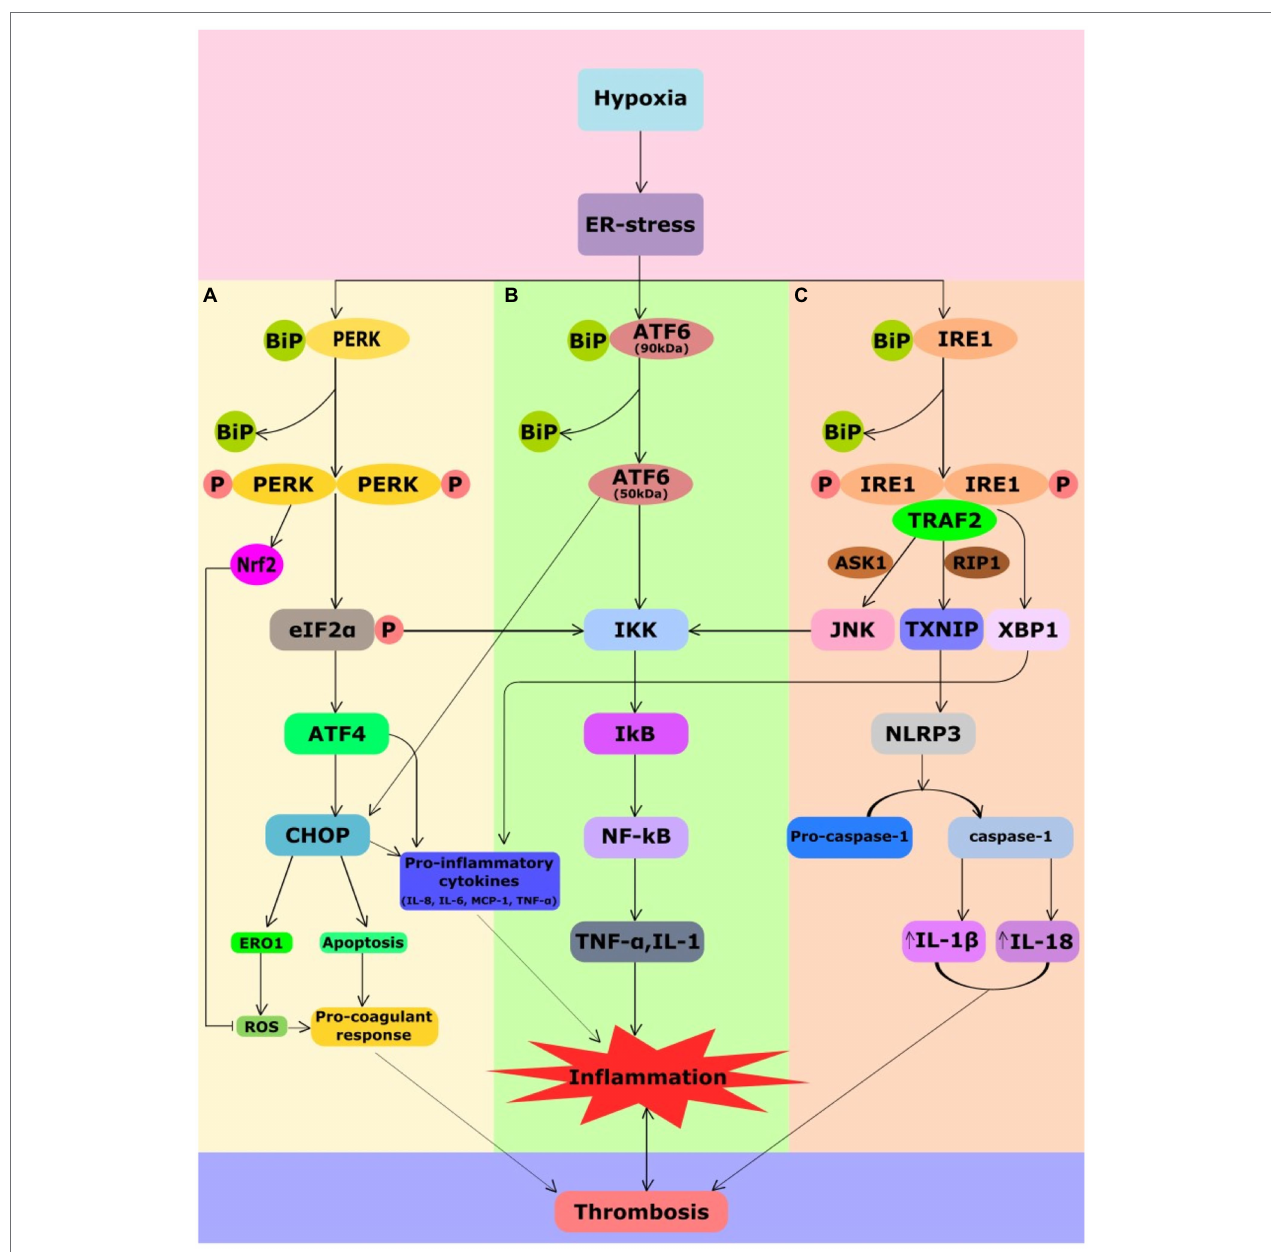
FIGURE 2 | Crosstalk between UPR, inflammatory and coagulation pathways in hypoxia-induced thrombosis. Hypoxia causes ER stress that leads to activation of UPR signaling. UPR signaling comprises three sensor proteins PERK, IRE1, and ATF6. All the three branches of sensor proteins could cause inflammation. Under normal conditions, UPR sensor proteins are bound to ER chaperone, BiP, due to which these sensors remain inactivated. During ER stress, BiP dissociates from them leading to their activation. (A) Phosphorylation of eIF2a by PERK attenuates translation but selectively favors ATF4 translation. ATF4 favors CHOP expression that mediates generation of ROS, apoptosis, and release of pro-inflammatory cytokines promoting inflammation and pro-coagulant response. Although PERK-mediated Nrf2 has an antioxidant response, chronic ER stress can still lead to inflammation and pro-coagulant response. PERK-mediated attenuation of translation leads NF-kB translocation to the nucleus that regulates cytokine encoding TNF- α and IL-1 genes. (B) ATF6 branch of UPR also mediates expression of CHOP and NF-kB promoting inflammation. (C) Activated IRE1 splices XBP1 pre-mRNA to yield the spliced XBP1 mRNA to induce the production of the inflammatory cytokines IL-8, IL-6, MCP1, and TNF- α . IRE1 also induces elevation of thioredoxin-interacting protein (TXNIP), which activates the NLRP3 inflammasome that promotes elevation of IL-18 and IL-1 β . Activated IRE1 α also recruits TRAF2, which activates JNK and IKK leading to NF-kB expression. All of these processes potentiate venous thrombosis in response to hypoxia. ASK1, apoptosis signal-regulated kinase 1; ATF4, activating transcription factor 4; ATF6, activating transcription factor 6; BIP, binding immunoglobulin protein; CHOP, C/EBP homologous protein; ER, endoplasmic reticulum; ERO1, ER oxidoreductin 1; IKK, I kappa B Kinase; IRE1, inositol-requiring enzyme 1; IL-18, interleukin-18; IL-1B, interleukin-1 β ; JNK, c-Jun N-terminal kinase; NF- κ B, nuclear factor κ -light-chain-enhancer of activated B cells; MCP-1, monocyte chemoattractant protein 1; Nrf2, nuclear factor erythroid 2-related factor-2; P, phosphorylation; PERK, protein kinase RNA-like ER kinase; RIP1, receptor-interacting serine/threonine-protein kinase 1; ROS, reactive oxygen species; TRAF2, tumor necrosis factor TNF receptor-associated factor-2; TXNIP, thioredoxin interacting protein; and XBP1, X-box binding protein